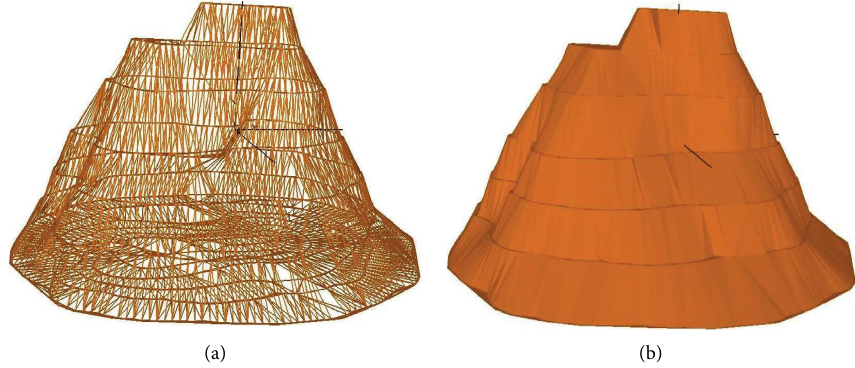
Figure 10: Tree-dimensional model of the mountain: (a) grid model and (b)